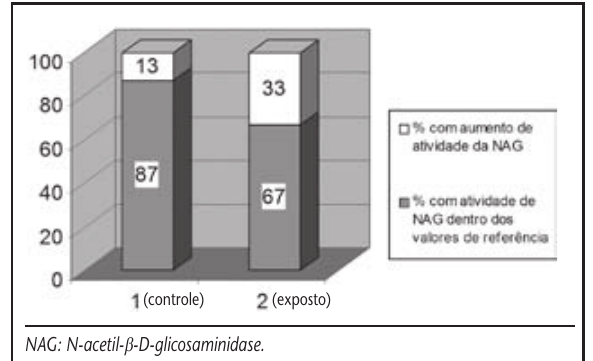
NAG: N-acetil- β Figura 1 – Diferenças de atividade da NAG entre o grupo-controle e o grupo exposto ao chumbo em função do valor de referência de Horak et al . (10)